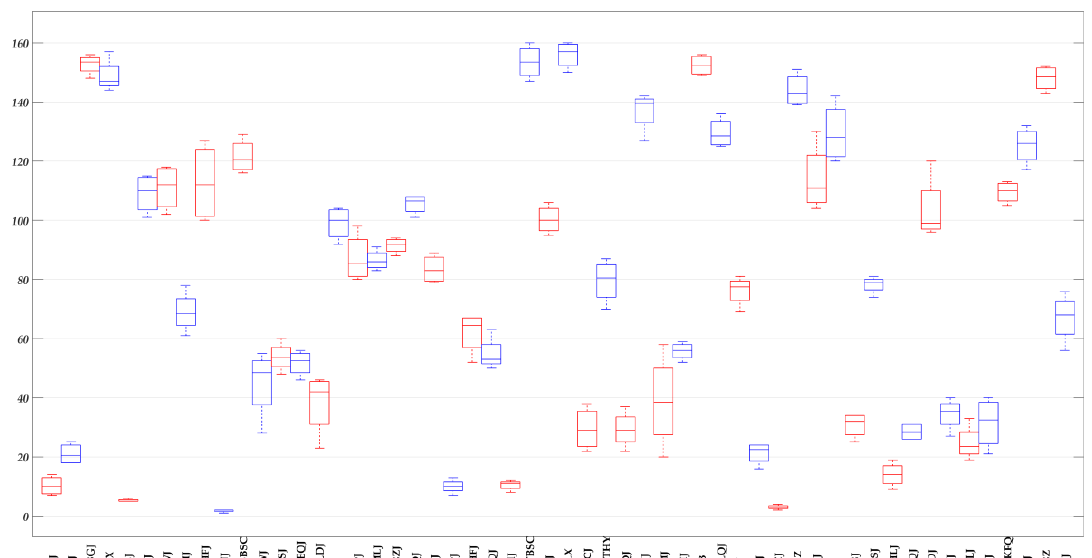
Figure 4. Changes in global criminal ranking.